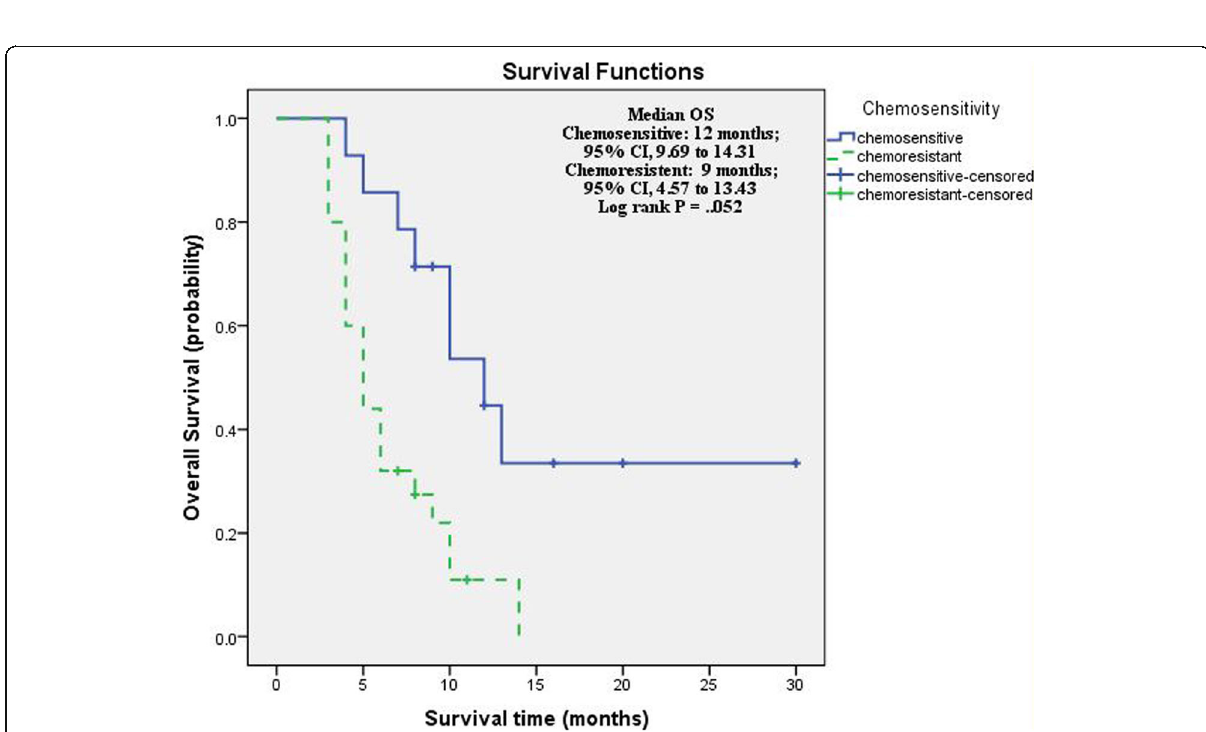
Fig. 5 Kaplan-Meier plot: overall survival according to chemosensitivity to prior anthracycline. CI confidence interval, OS progression-free